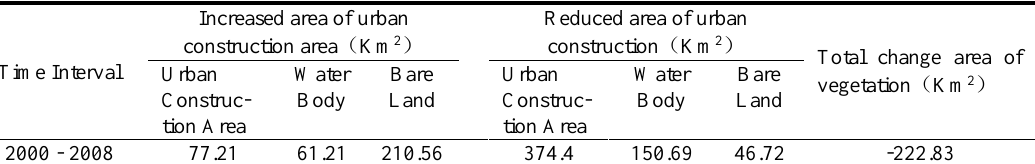
Table 11 Vegetation area change from the year 2000 to 2008